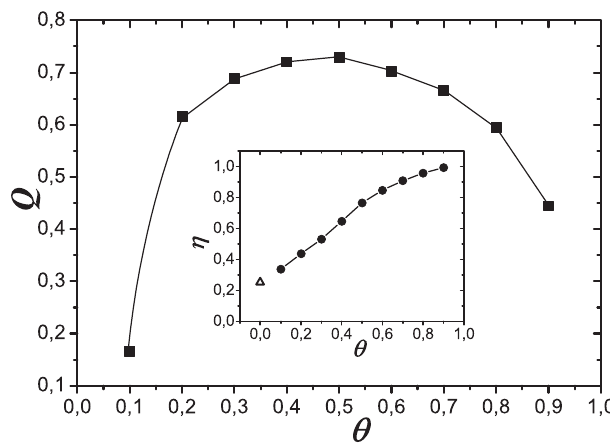
Figure 5. Overlap and PHN-Families By partitioning the network with the overlap procedure for increasing value of h , we separated the PHN into regions of increasing compact- ness. The maximum value of the modularity measure Q (see Materials and Methods) allowed us to identify the optimal cutoff value to partition the PHN into families of homologous proteins. (Main Graph) Q is shown as a function of h . The maximum value of Q ¼ 0.723 is found for h ¼ 0.5. (Inset Graph) The dark circles represent the compactness index g after the partitioning (see Materials and Methods) as a function of h . The white triangle is the value of g of the original PHN for e ¼ 10 (cid:1) 5 , which corresponds to the limiting value h ¼ 0. doi:10.1371/journal.pcbi. 0020173.g005